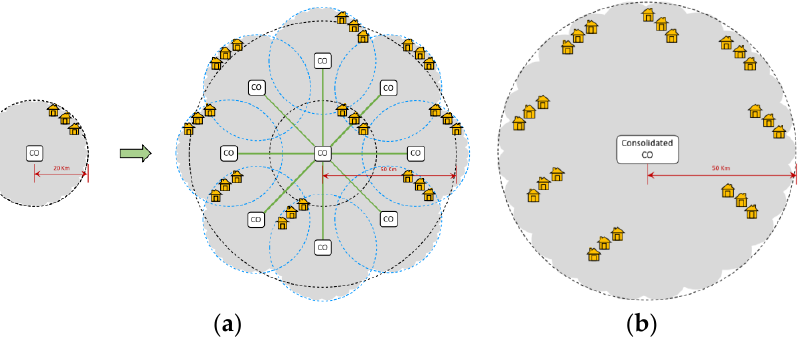
Figure 18. Architecture used to cover an access network with a 50 km radius using ( a ) typical PON and ( b ) super-PON [56].